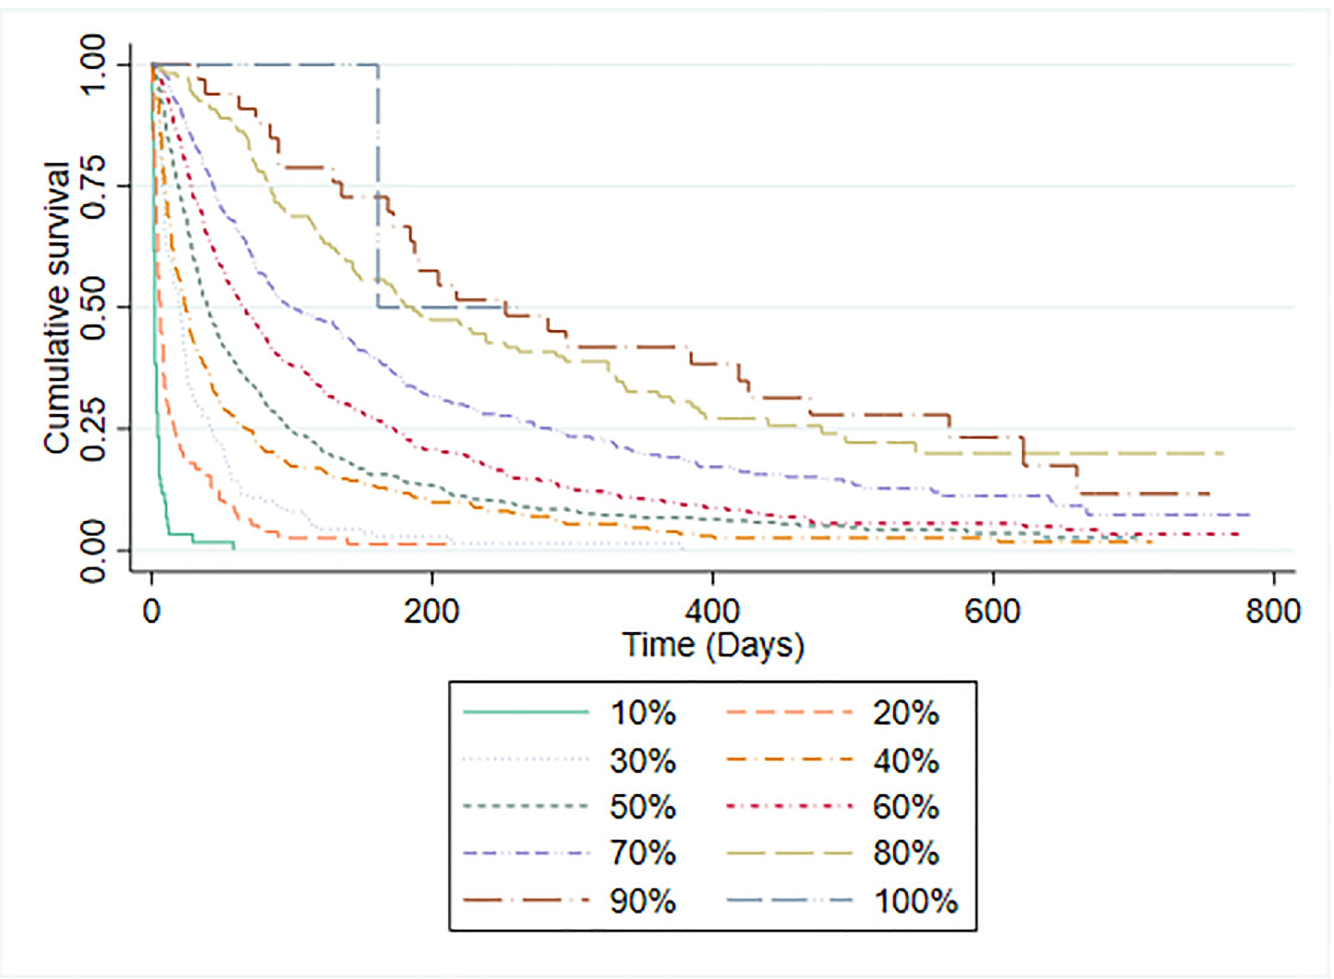
Fig 3. Kaplan-Meier survival curves by PPS